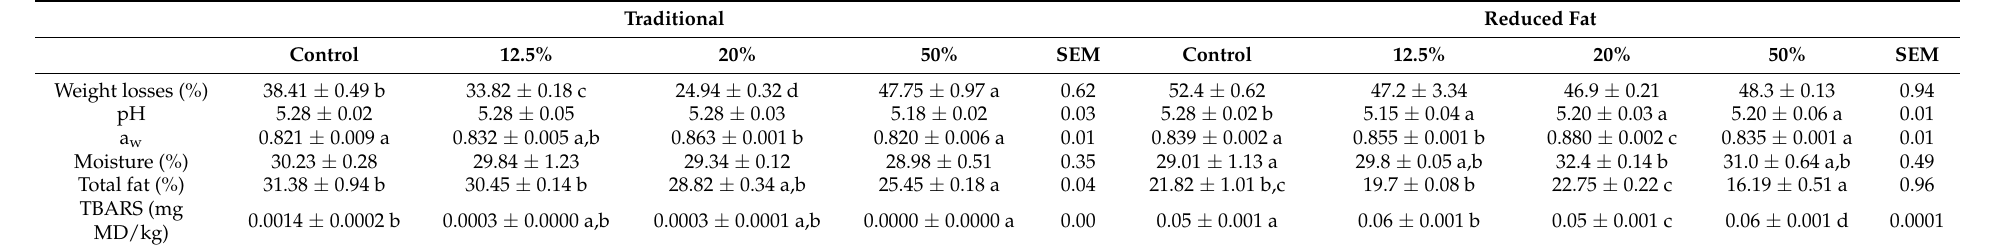
Table 2. Mean values, standard deviation, and standard error of the mean (SEM) of the physico-chemical properties for the traditional and reduced fat “Chorizo Zamorano” formulations at the end of